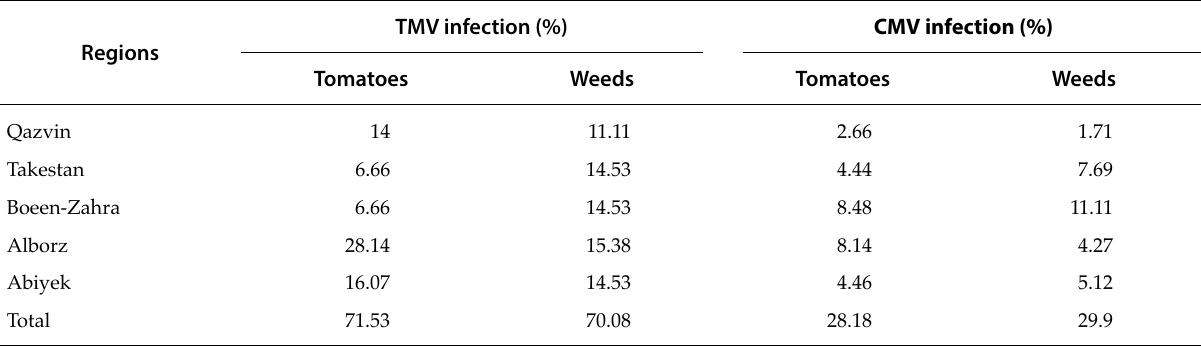
Table 2. incidence of Tobacco mosaic virus (TMV) and Cucumber mosaic virus (CMV) in weeds and tomatoes in the five regions of Qazvin